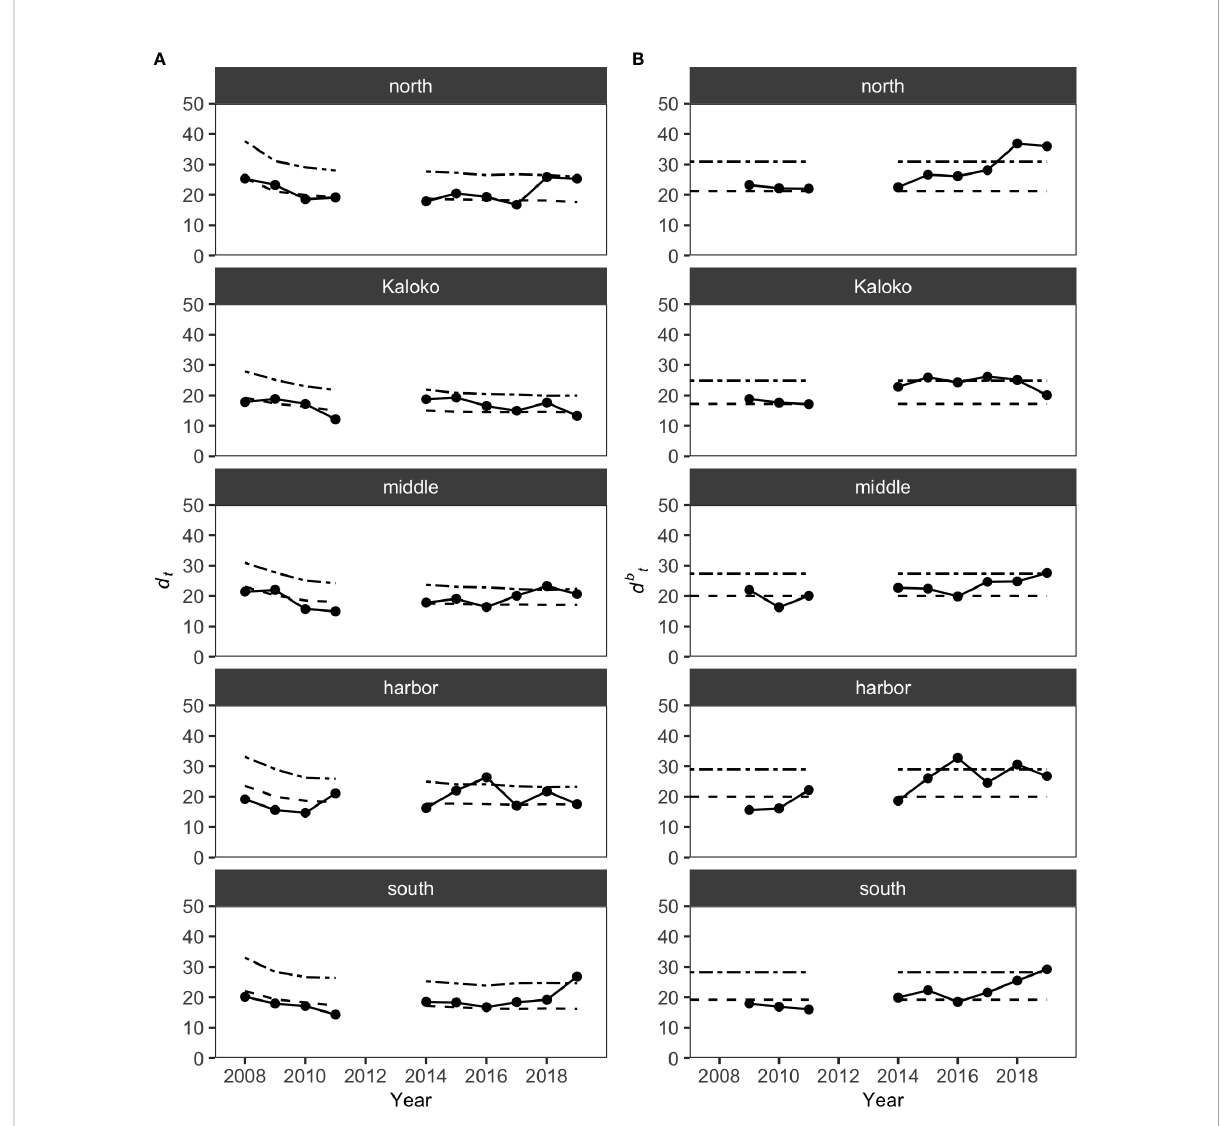
FIGURE 3 Results of MCCs for KAHO fi sh assemblages showing (A) d t values and (B) d b t values. Dashed lines on each plot show 50 percentile con fi dence bounds as representations of the temporal trends, and dash-dotted lines show 95 percentile con fi dence bounds as upper con fi dence limits under which the status of the regions were considered stable or within natural